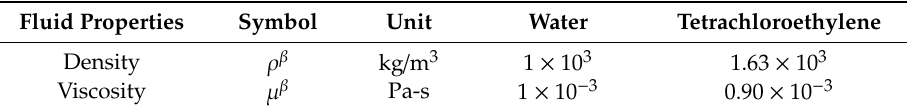
Table 3. Fluid properties.